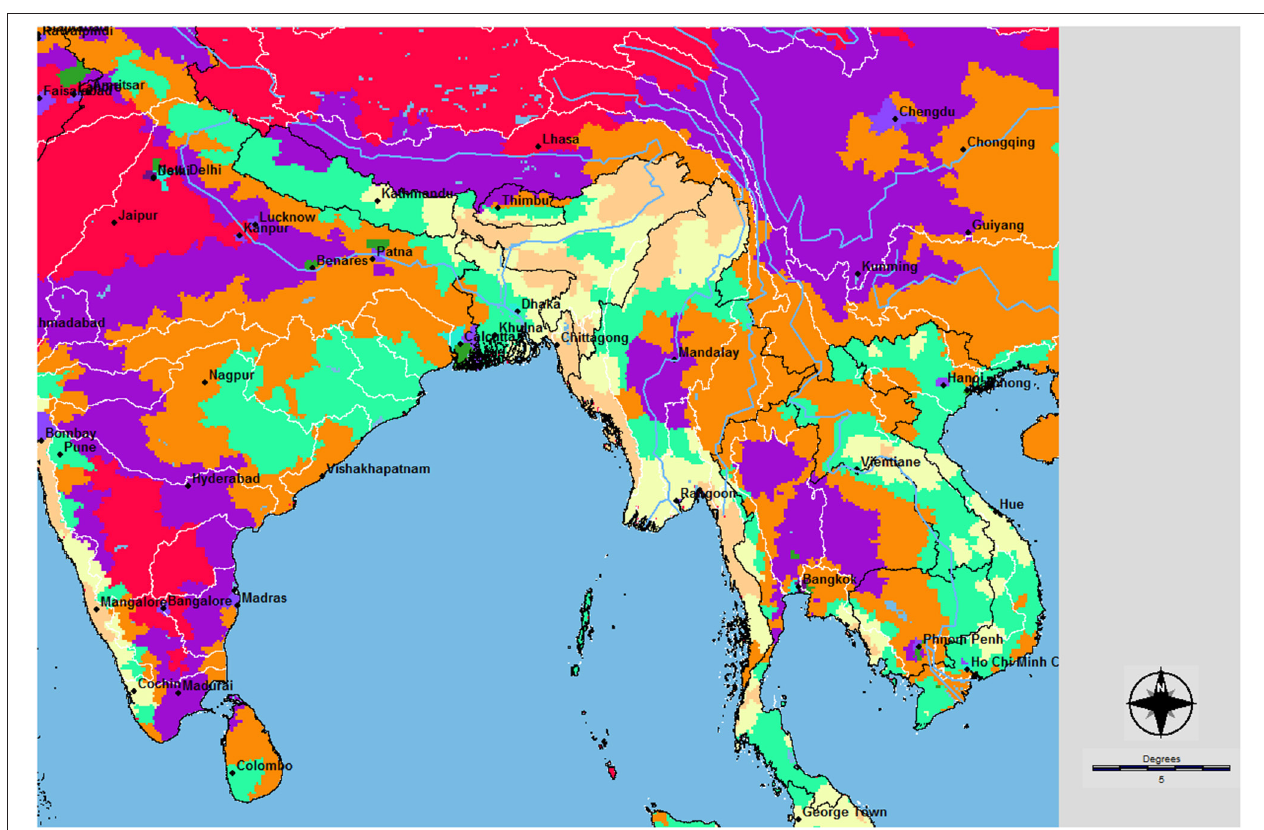
FIGURE 7 | Results of cluster analysis with five variables, to guide the identification of water management